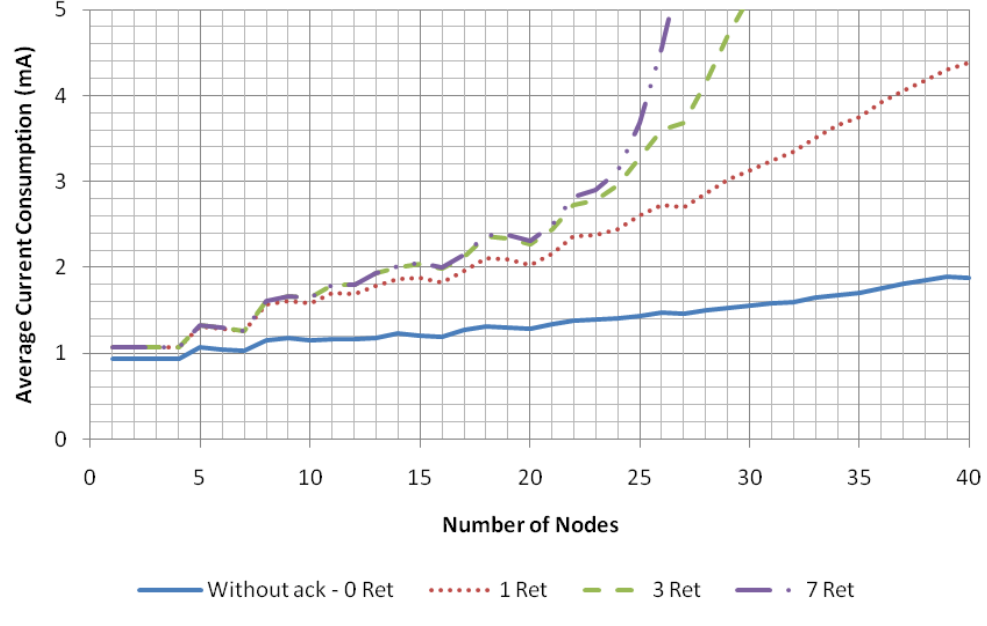
Figure 5. Average current consumption for the unslotted CSMA/CA